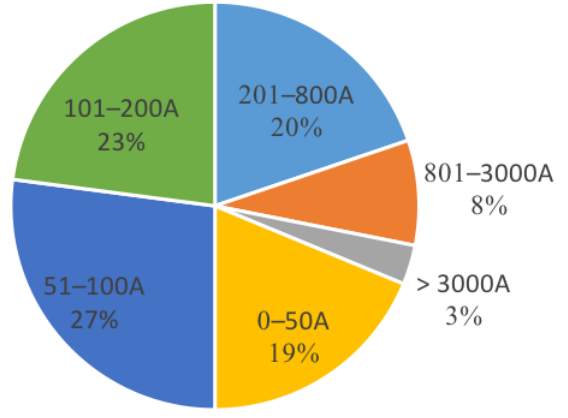
Figure 5. Rating of current